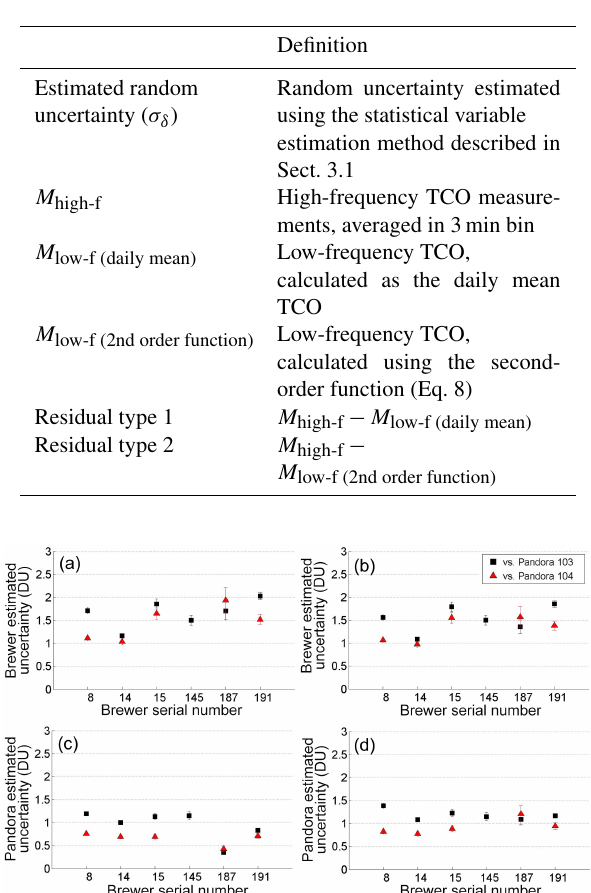
Table 2. Definition of terminologies used in the uncertainty estima- tion.